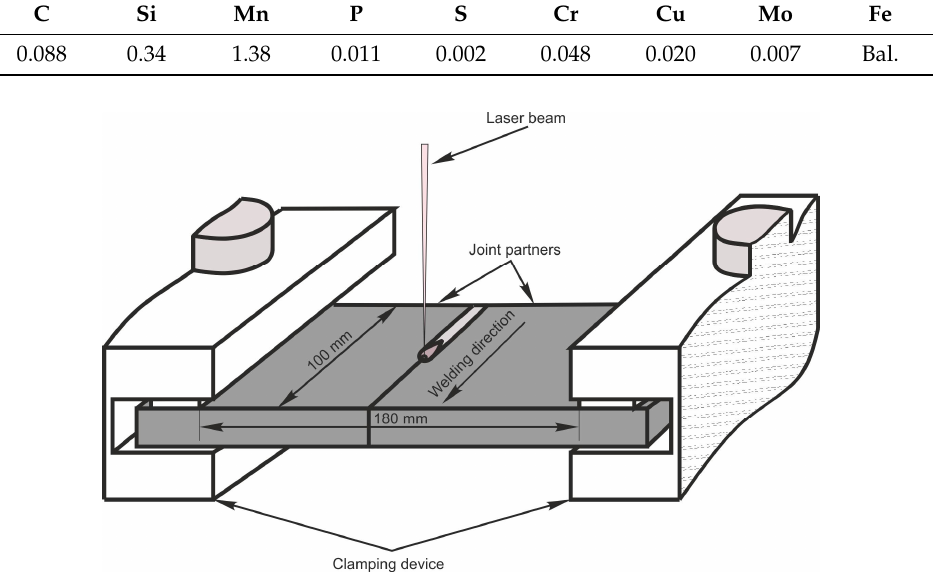
Figure 2. Schematic illustration of the experiments.